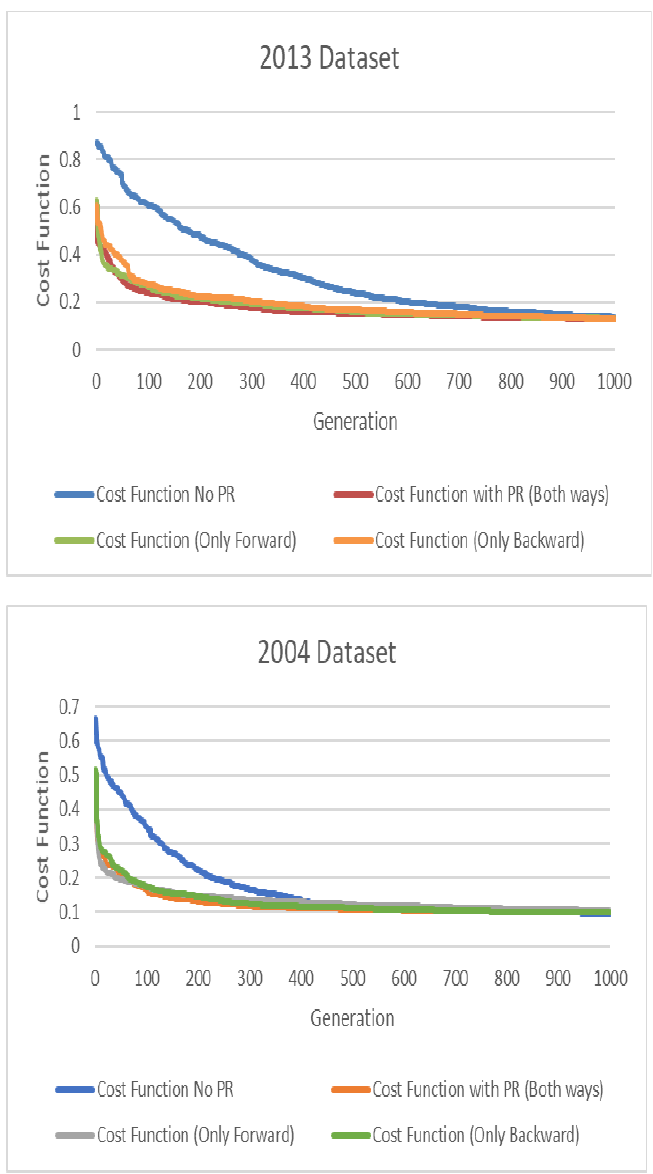
Figure 9. Experimental results of the PR implementation per generation.